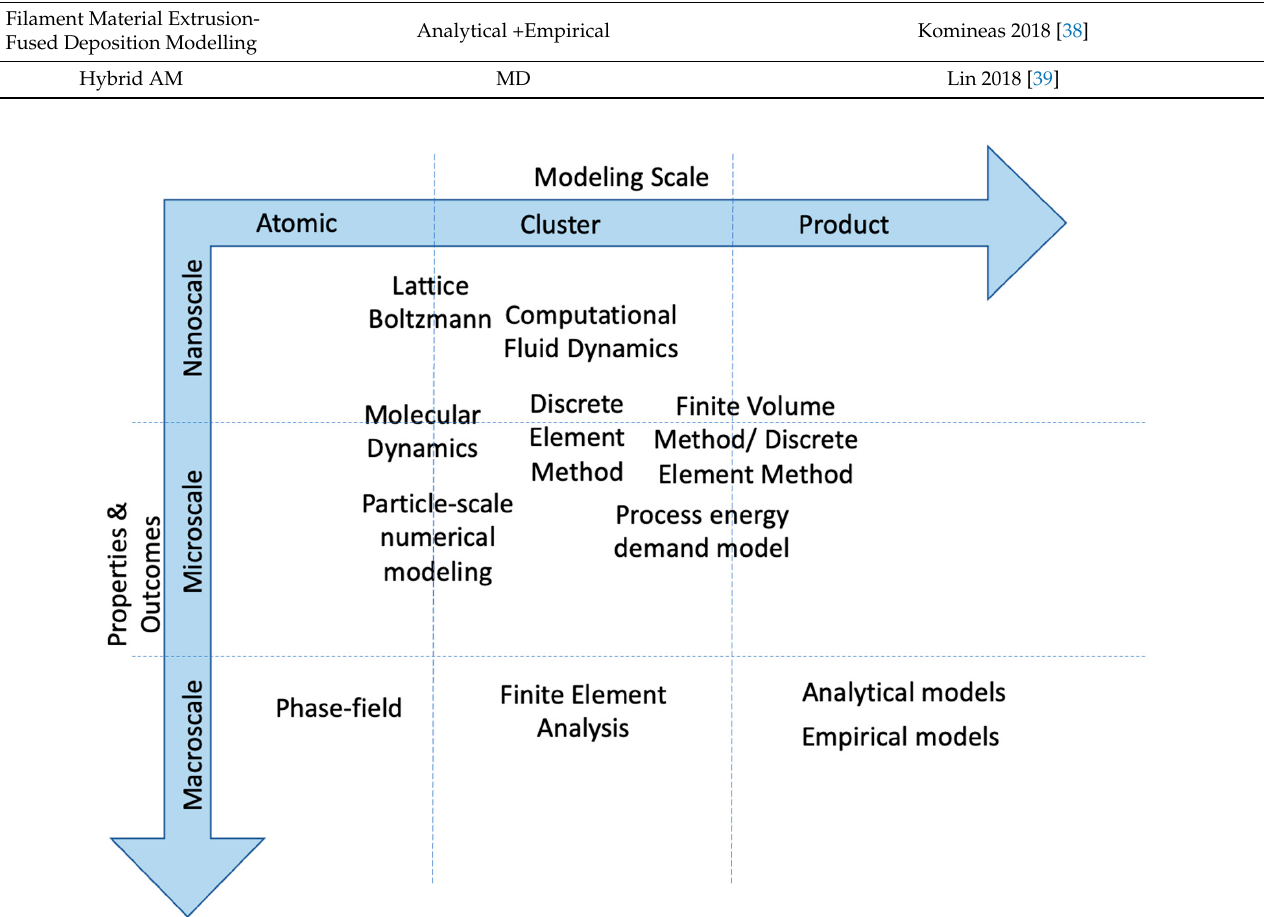
Figure 1. Distribution of models according to the selection of scale, e.g., atomic, particle or product scale, and the properties or outcomes scale, e.g., nanoscale, microscale or macroscale.